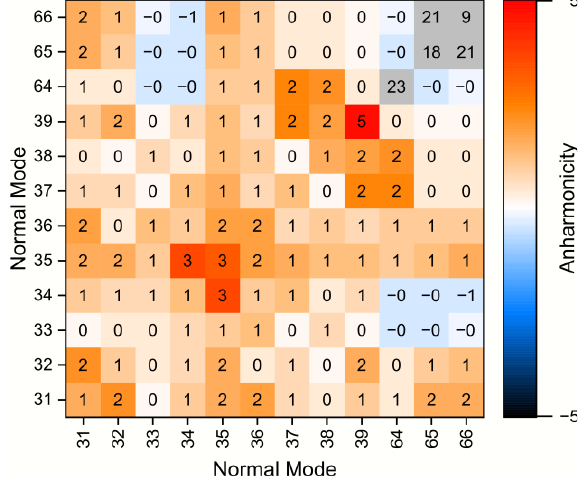
Figure 5. Matrix representation of intramode anharmonicities ∆𝜔 1−2𝑎 and intermode anharmonicities ∆𝜔 𝑎/𝑏 of νCO/CN vibrations (modes #64 – #66) and δ/νFe–CO/CN vibrations (modes #31 – #39), as calculated for the Ni a - S state of [NiFe] hydrogenase. Only the indicated vibrational degrees of freedom were included in the anharmonic analysis. δ— bending vibration; ν— stretching vibration.